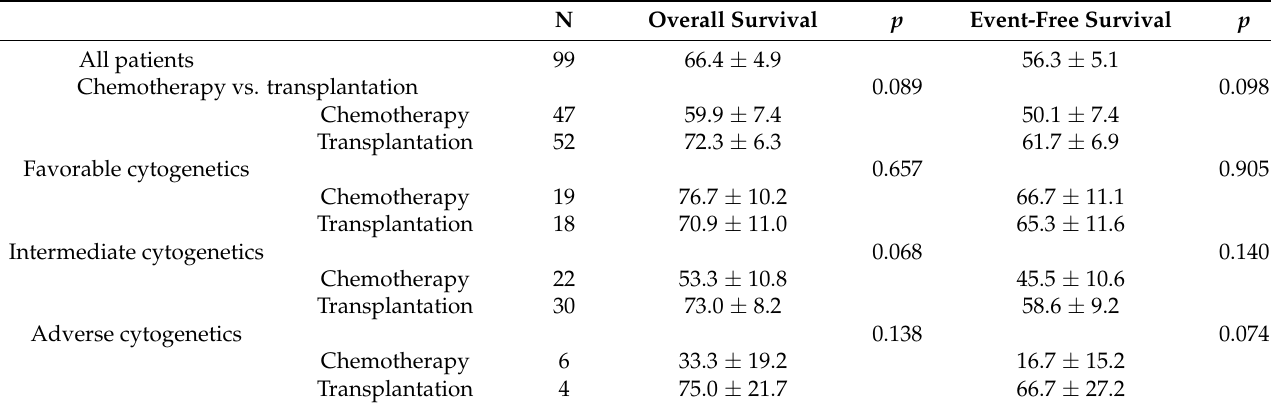
Table 4. Comparing survival between chemotherapy and transplantation in CR1 according to cytogenetics. N Overall Survival p Event-Free Survival p All patients Chemotherapy vs.